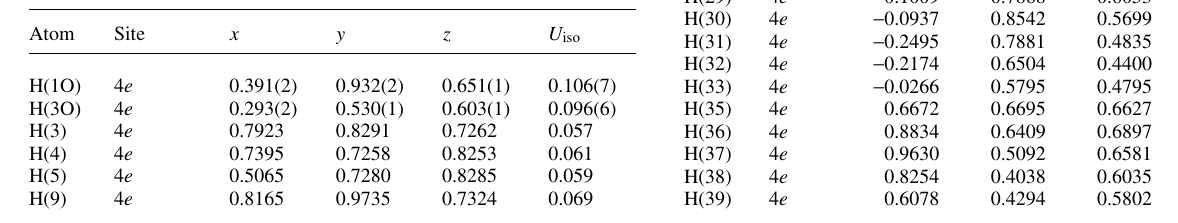
Table 2. Atomic coordinates and displacement parameters (in Å 2 ) .